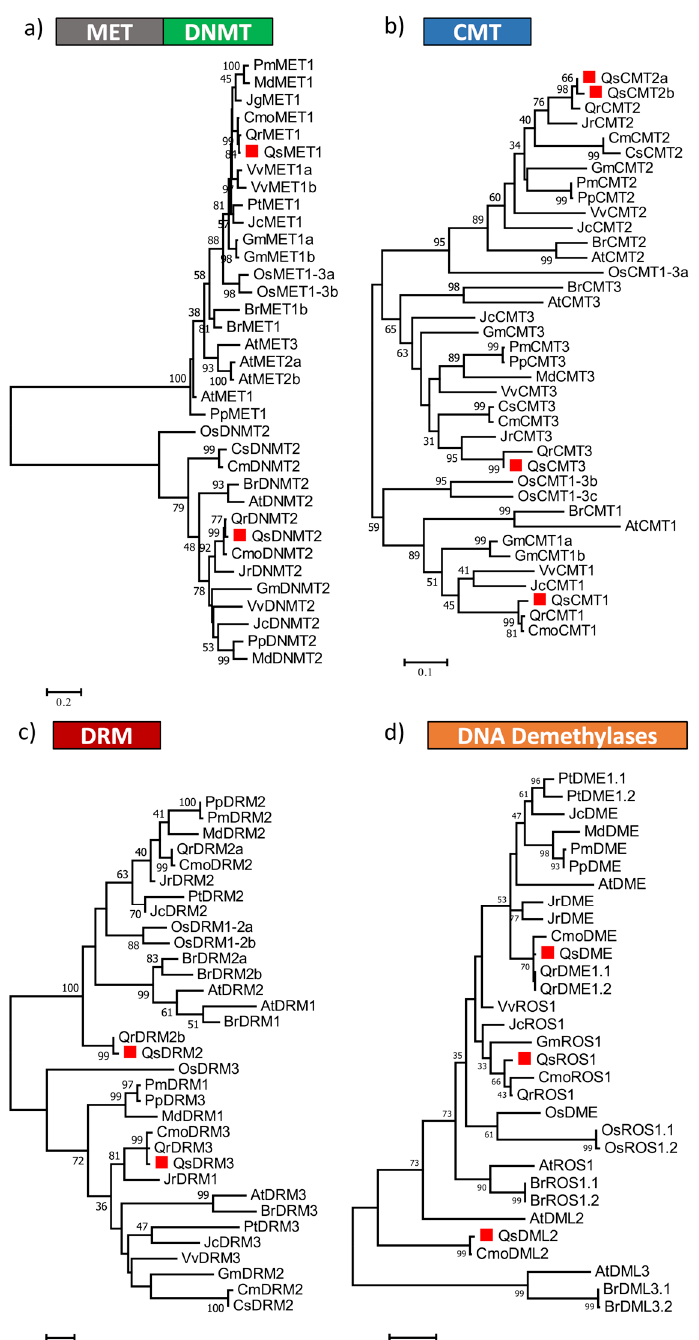
Figure 2. Phylogeny of DNA methyltransferase proteins of ( A ) Methyltransferase (MET), DNA Methyltransferase homolog 2 (DNMT), ( B ) Chromomethylase (CMT) family, ( C ) DRM family, and of ( D ) DNA Demethylase proteins. The DNA Mtase domain and all DNA demethylase conserved domains of Quercus suber L. (Qs), Arabidopsis thaliana (L.) Heynh. (At), Brassica rapa L. (Br), Glycine max (L.) Merr. (Gm), Jatropha curcas L. (Jc), Populus trichocarpa Torr. & A.Gray ex Hook. (Pt), Prunus persica (L.) Batsch (Pp), Prunus mume (Siebold) Siebold & Zucc. (Pm), Vitis vinifera L. (Vv), Cucumis melo L. (Cm), Cucumis sativus L. (Cs), Juglans regia L. (Jr), Castanea mollissima Blume (Cmo), Quercus robur L. (Qr) and Oryza sativa L. (Os) were aligned using ClustalW and used to infer the evolutionary history using the Maximum-likelihood method. The evolutionary distances (left side scale bar) were computed using the Jones-Taylor-Thornton (JTT) correction model. The numbers at the nodes represent bootstrap values from 1000 replicates. The Q. suber proteins are indicated with a red square.